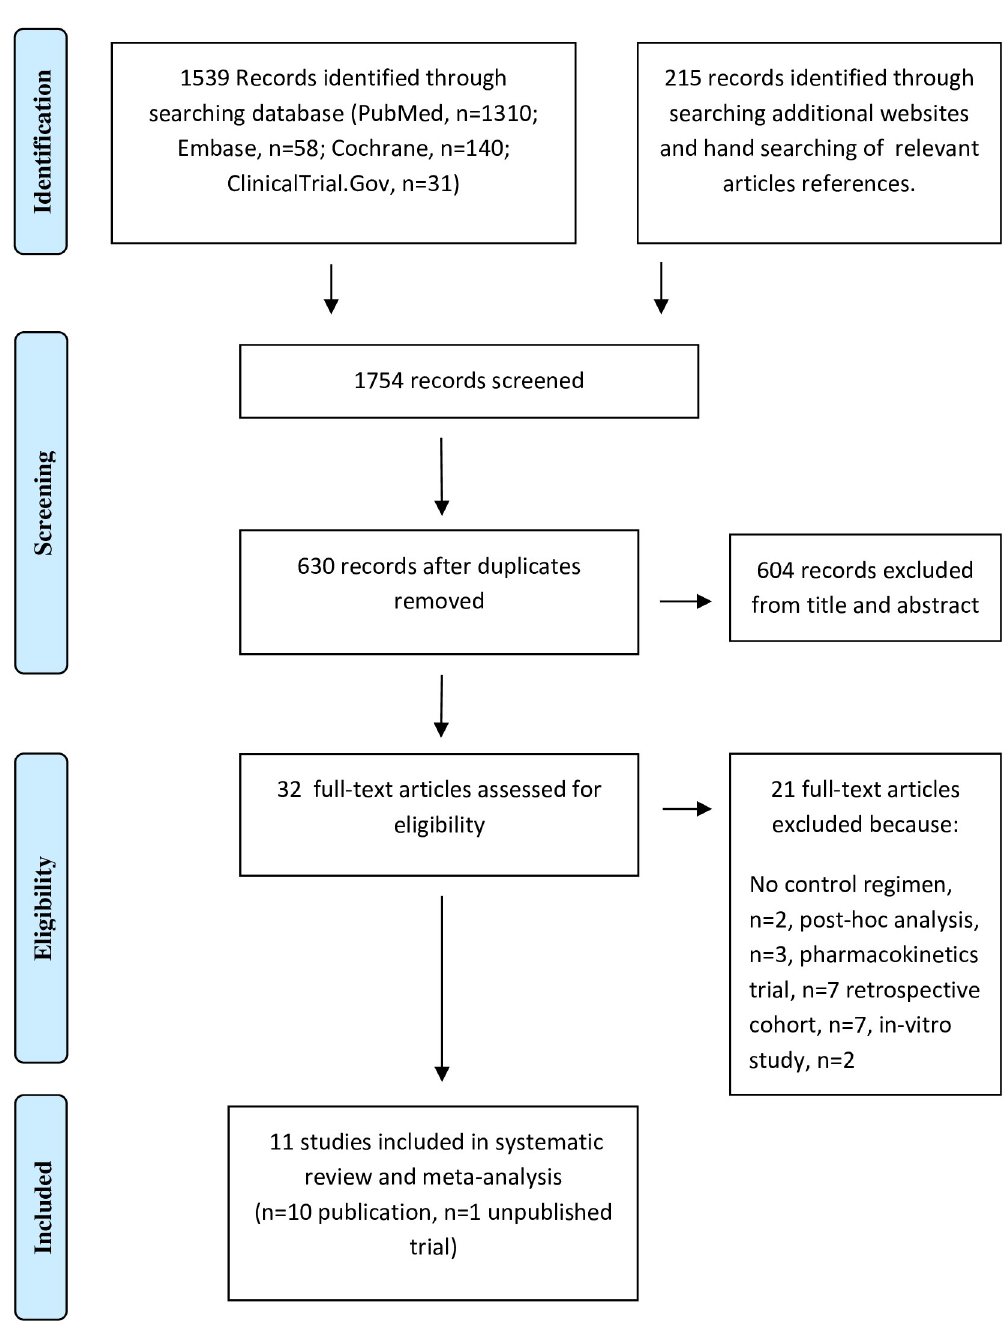
Fig 1. PRISMA flow diagram of the